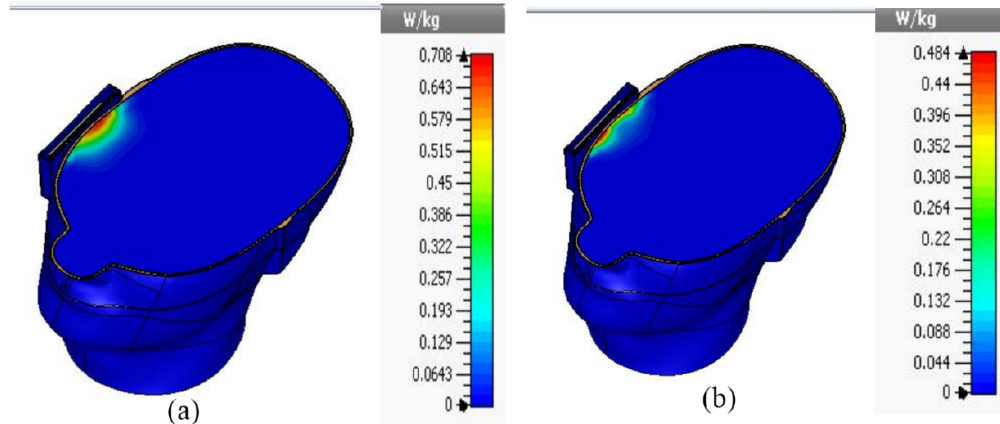
Figure 8. Simulated 1 g SAR values of the proposed antenna ( a ) at 1.8 GHz and ( b ) at 2.4